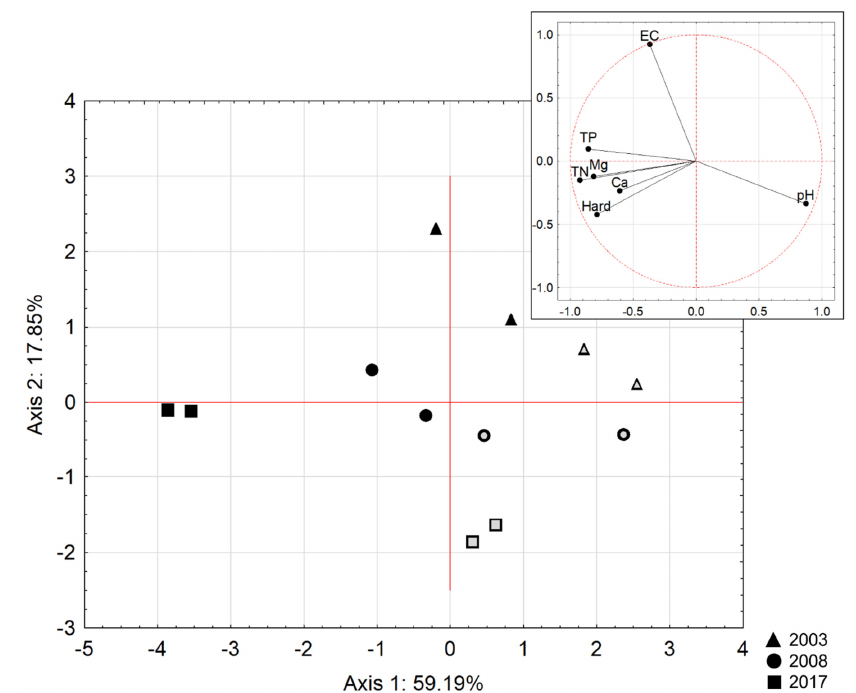
Figure 5. The principal components analysis (PCA) for water analyses in Lubi ń skie Lake performed in 2003 [43], 2008 (unpublished data), and 2017—differentiation across the selected hydrochemical characteristics (preceded by factor analysis). Gray color indicates samples taken in August, and black—those taken in April.